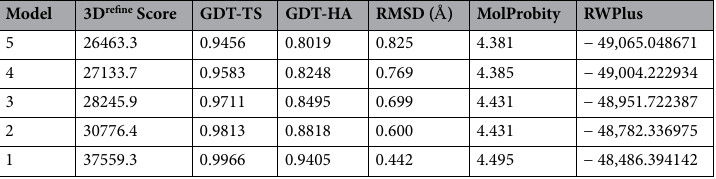
Table 3. Results of the model refinement. Models with higher GDT-TS, GDT-HA, and RMSD values and lower 3Drefine Score, RWplus, and MolProbity values are of higher quality.